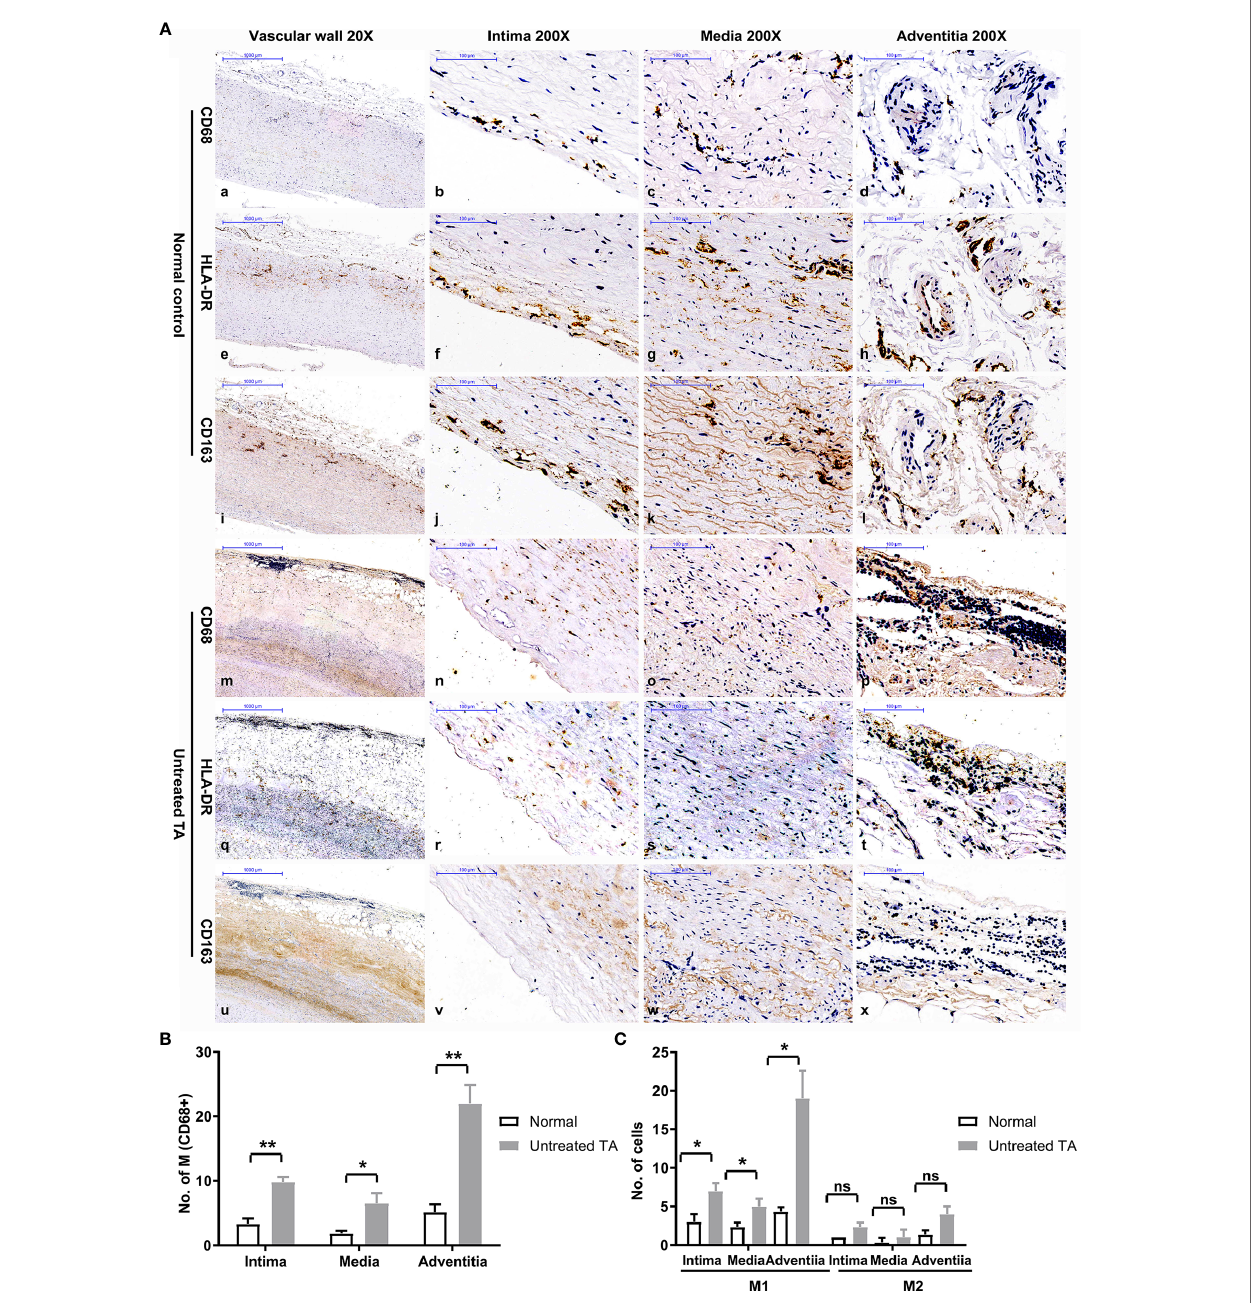
FIGURE 2 | Distribution and phenotype of macrophages in controls and untreated patients with TA. (A) Representative immunohistochemistry images of CD68, HLA-DR and CD163 positive cells in control arterial specimens (CD68:a-d; HLA-DR: e-h; CD163: i-l) and TA aortic specimens (CD68: m-p; HLA-DR: q-t; CD163: u-x); image a, e, i, m, q, u-20X, the remaining images-200X. (B) The number of macrophages in different layers of control arterial specimens and TA aortic specimens. (C) Number of M1 or M2 macrophages in different layers of control specimens and TA aortic specimens. *< 0.05; **< 0.01; ns, no signi fi